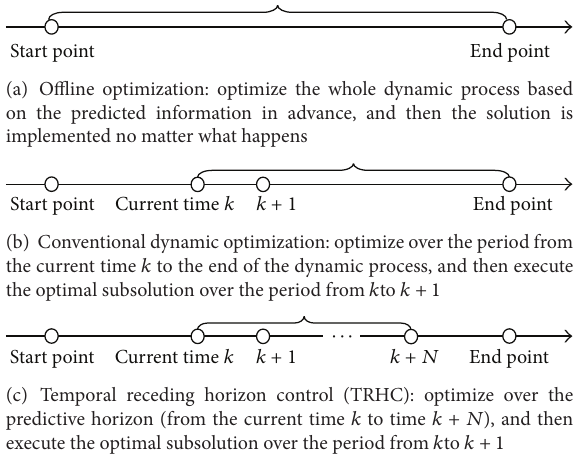
Figure 2: Illustration of temporal receding horizon control